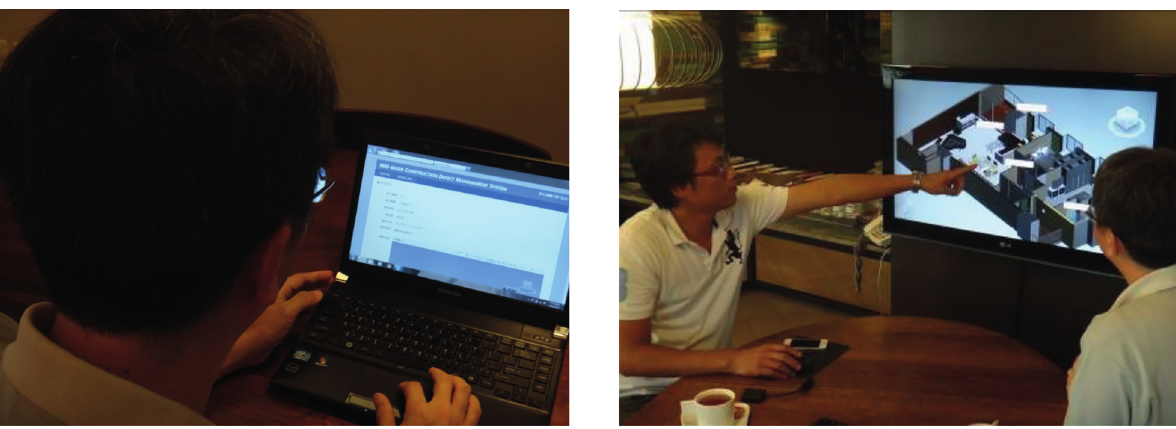
Fig. 6. On-site quality engineers and managers using webcam-enabled tablet for